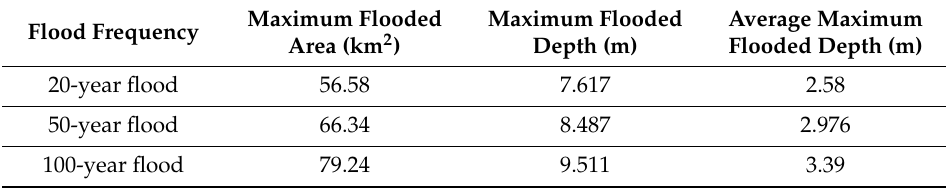
Table 4. Flooded characteristic data of each